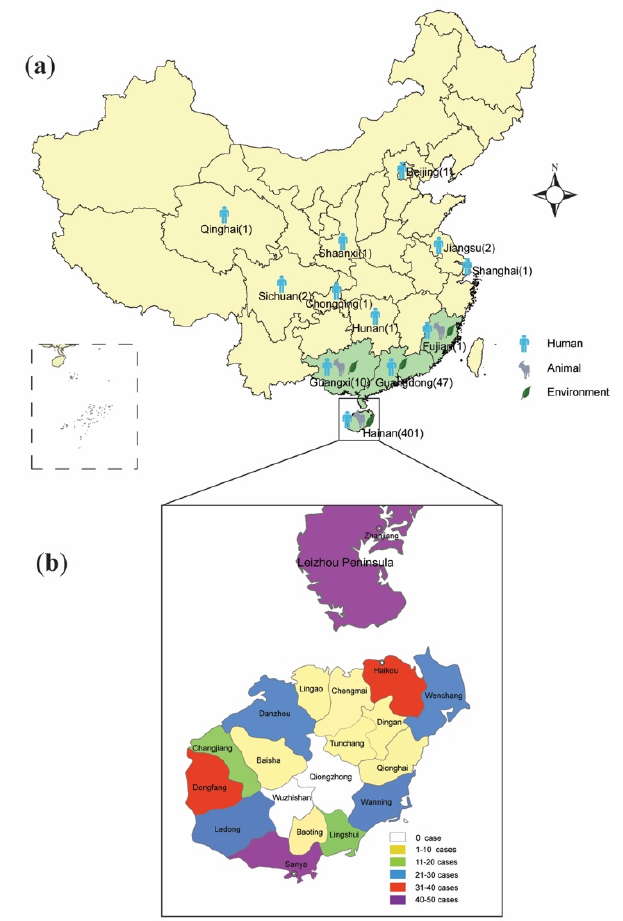
Figure 2. Location of Burkholderia pseudomallei and melioidosis cases in China. ( a ) The distribution of endemic areas ( n = 4, with green shading) and melioidosis cases in mainland China, with locations of environmental isolation of B. pseudomallei and indigenous or imported human/animal cases of melioidosis indicated 1 ; ( b ) The distribution of melioidosis cases according to different prefectures in Hainan (data only available for 289 of 401 cases) and in the Leizhou Peninsula (46 cases) of Guangdong, China. 1 The number of human cases for each province was indicated in parentheses. The patients outside the four endemic provinces all have a history of residence or travel to Hainan or overseas endemic areas and thus are deemed as imported cases.